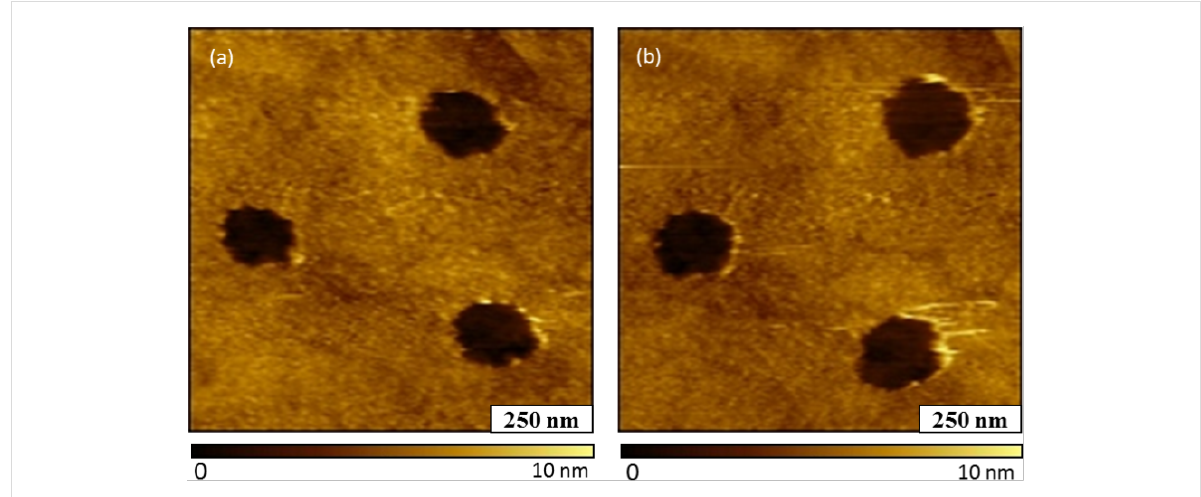
Figure 2: Attempted nanoshaving of the Au–Me Film on Au (111). (a) Topography image of nanopores within the film; (b) topography image acquired after nanoshaving; the film was not displaced.